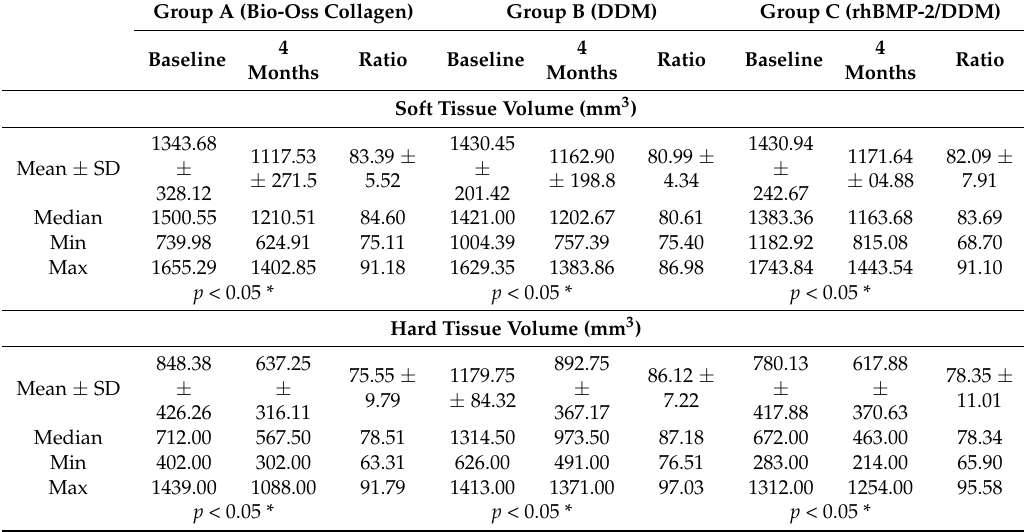
Table 2. Results of the volumetric